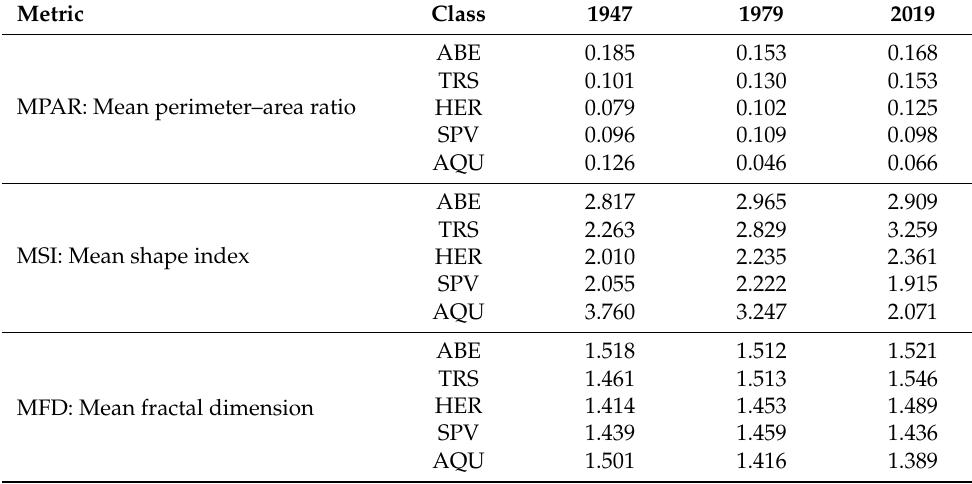
Table A3. Shape metrics at the class level, for 1947, 1979, and 2019.